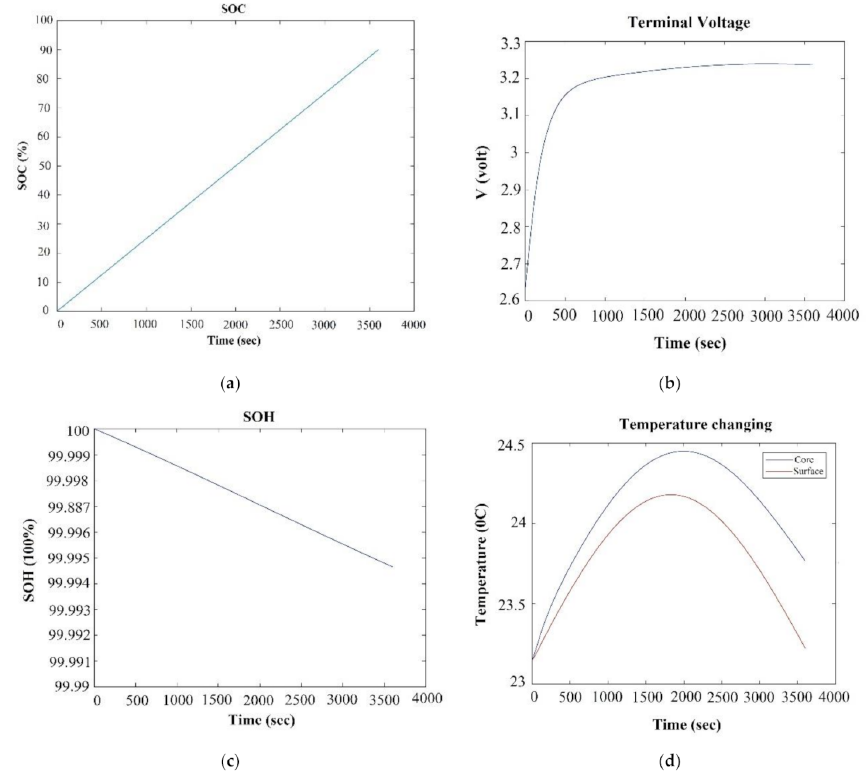
Figure 5. Systems outputs; ( a ) SOC%, ( b ) terminal voltage, ( c ) SOH%, and ( d ) temperature changing. With adding white noises to both surface temperature and terminal voltage data with SNR = 60, the generated synthetic data produced surface temperature and terminal voltage measurements. Figure 6 introduces these synthetic